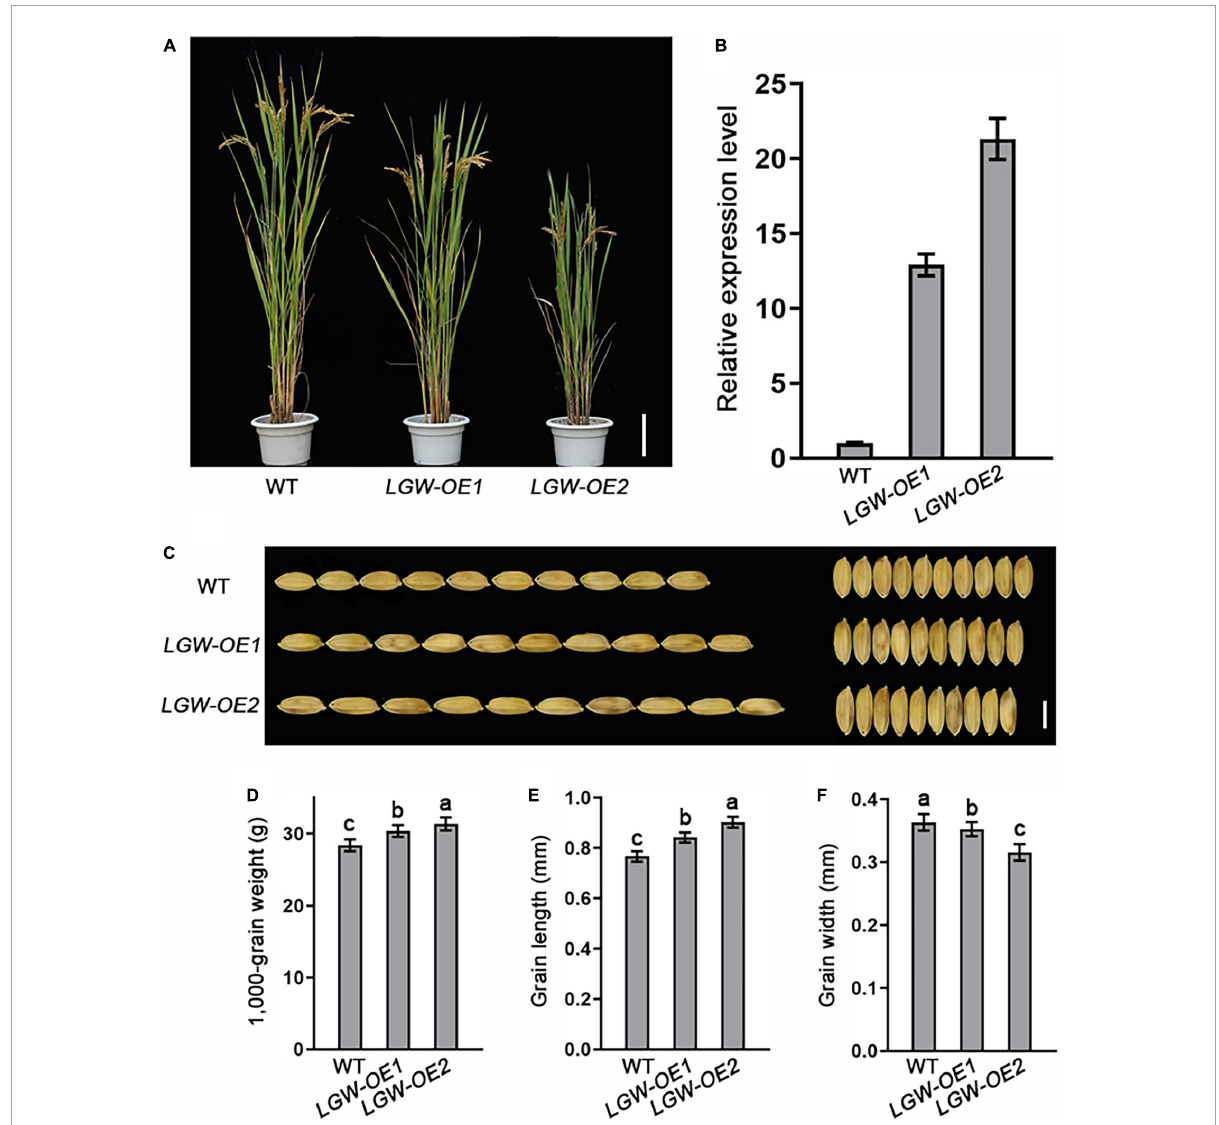
FIGURE5 Overexpression of LGW increases grain length. (A) Morphology of mature LGW-OE1 and LGW-OE2 plants. Scale bar = 10 cm. (B) The relative expression level of LGW in WT, LGW-OE1, and LGW-OE2 lines. (C) Grain size, bar = 0.5 cm. (D) 1,000-Grain weight. (E) Grain length. (F) Grain width. Different letters denote significant differences ( P < 0.05) from Duncan’s multiple range